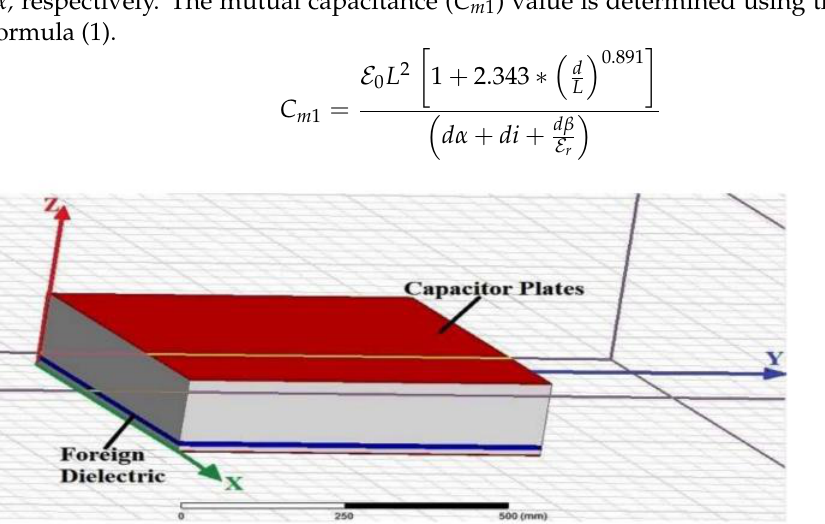
Figure 10. A dielectric foreign object in a single module CPT system in ANSYS MAXWELL environ-